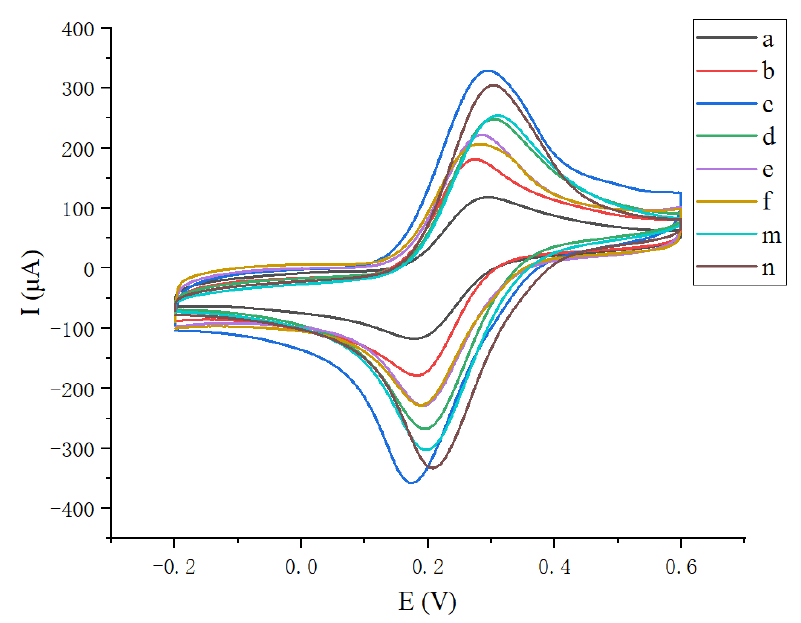
Figure 3. Cyclic voltammetry curves of bare GCE (curve a ), N-rGO@CMWCNTs/GCE (curve b ), N- rGO@CMWCNTs/CS@AuNPs/GCE (curve c ), Anti-CA125/N-rGO@CMWCNTs/CS@AuNPs/GCE (curve d ), BSA/Anti-CA125/N-rGO@CMWCNTs/CS@AuNPs/GCE (curve e ), CA125/BSA/Anti- CA125/N-rGO@CMWCNTs/CS@AuNPs/GCE (curve f ), N-rGO/CS@AuNPs/GCE (curve m ), CMWCNTs/CS@AuNPs/GCE (curve n ).